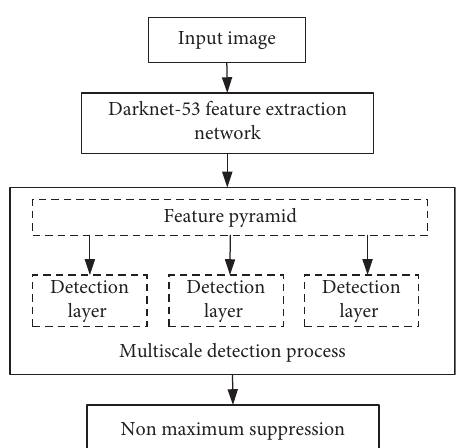
Figure 2: Multiscale prediction.